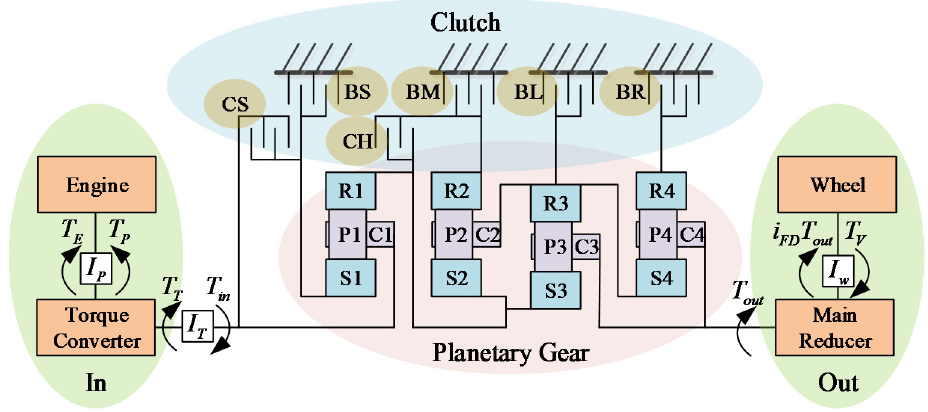
Figure 1. 6 + 2 speed automatic transmission (AT) powertrain system.